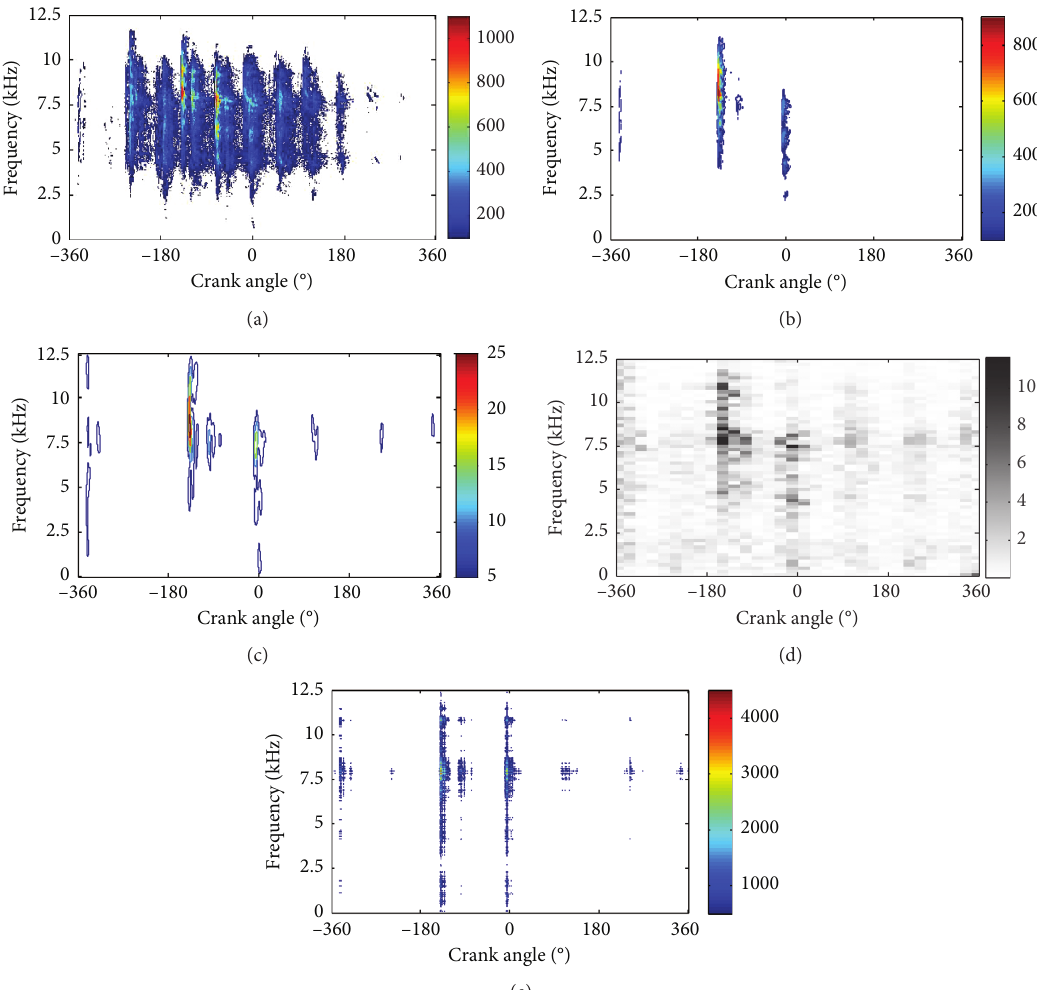
Figure 11: Different time-frequency representations of the vibration signal. (a) WVD distribution. (b) PWVD distribution. (c) STFT distribution. (d) Wavelet packet distribution. (e) Rihaczek